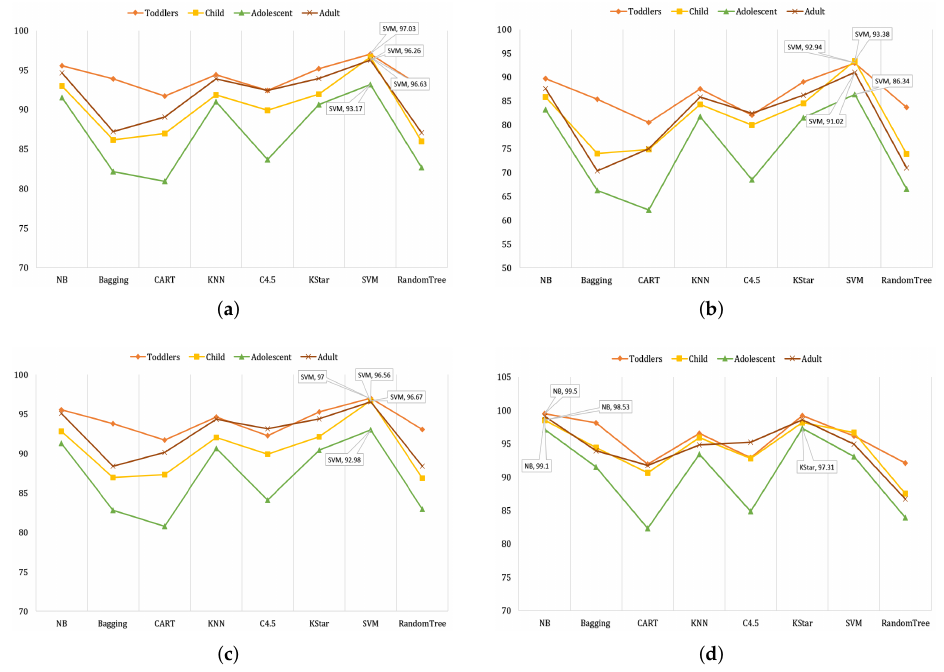
Figure 3. The average ( a ) accuracy, ( b ) kappa statistics, ( c ) F1, and ( d ) AUROC of the toddler, child, adolescent, and adult datasets of the